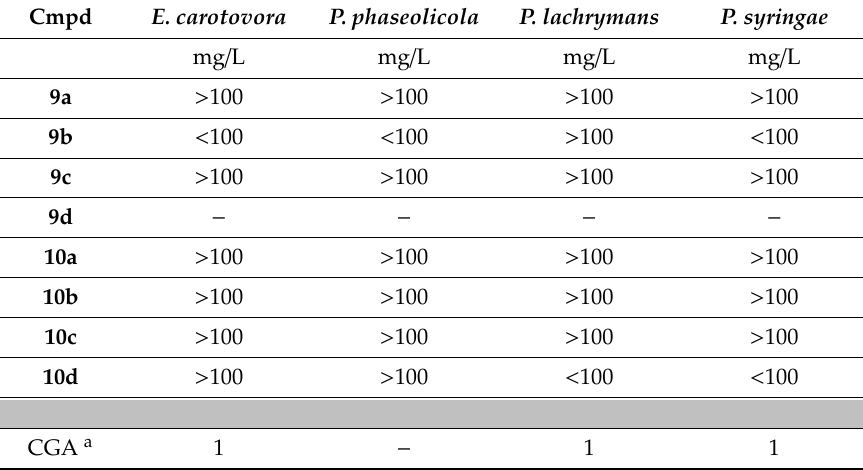
Table 4. Bacteriostatic activity MIC of selenocarbamates 9 , 10 at 100 mg / L.